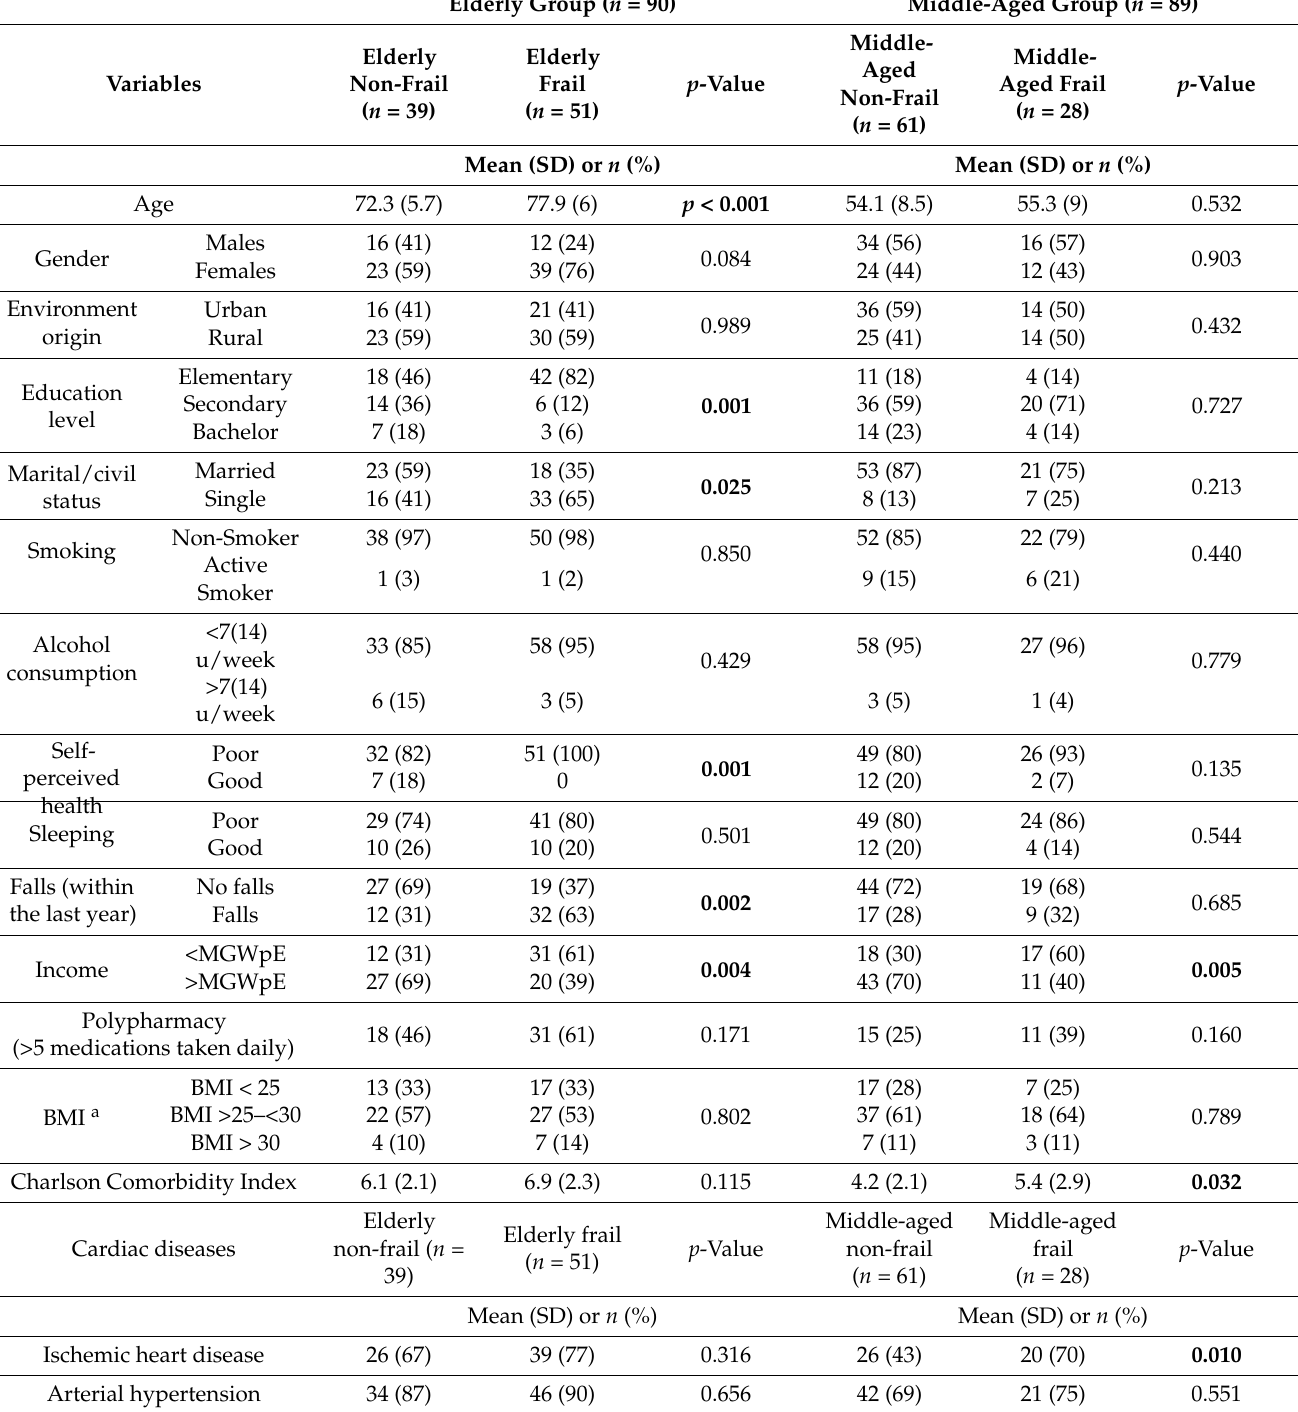
Table 2. Mean differences between elderly patients (non-frail and frail) and middle-aged patients (non-frail and frail) at baseline. Quantitative variables are expressed as mean (M) and standard deviation (SD), and qualitative variables as a percentage. Elderly Group ( n =